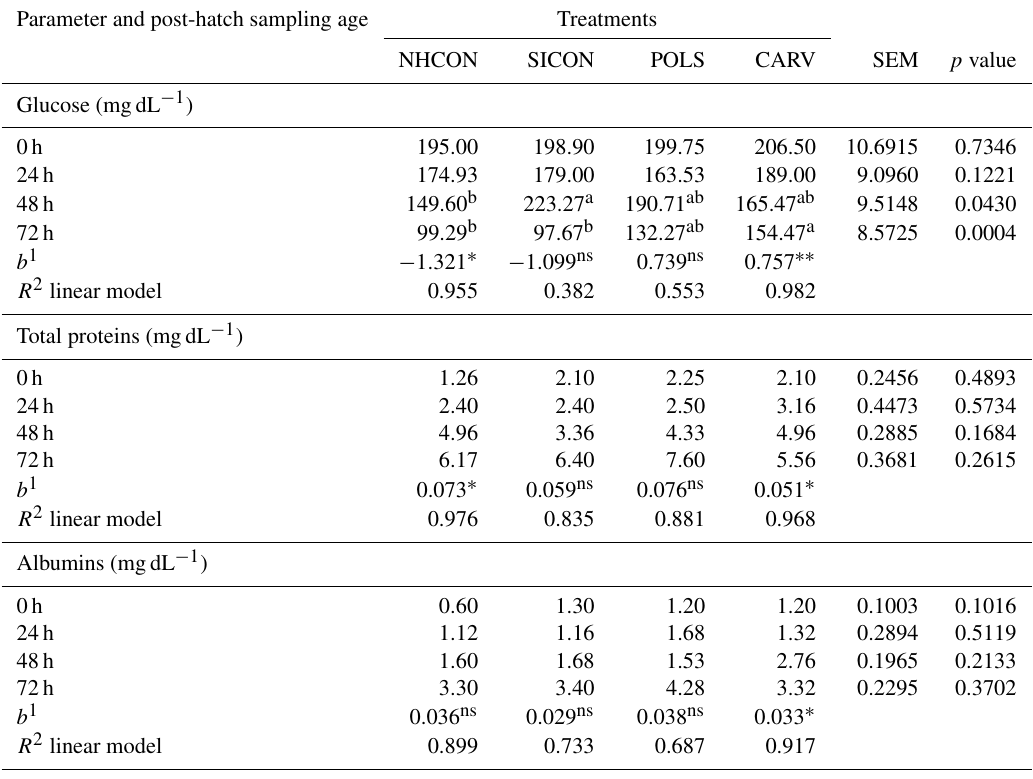
Table 3. Blood glucose, total protein, and albumin concentration in chicks subjected to experimental treatments, namely non-handled control (NHCON), sham injection control (SICON), polysorbate-80 injection (POLS) and carvacrol injection (CARV), in post-hatch sampling